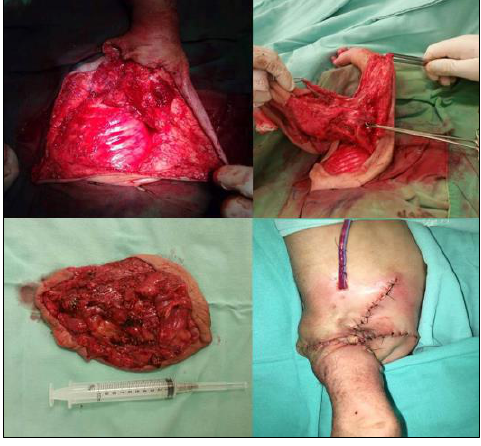
Figure 3: Steps of